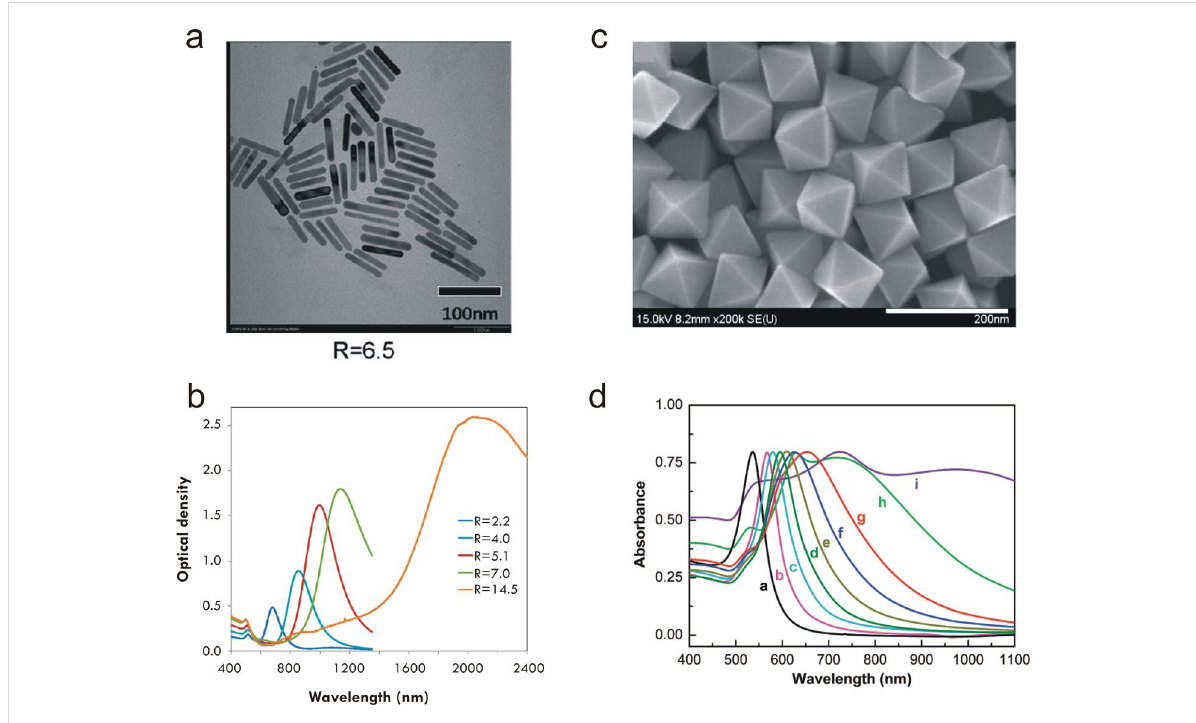
Figure 4: (a) TEM image of gold nanorods (AuNRs) with an aspect ratio R equal to 6.5. (b) UV–vis measurements showing the experimental spectra of longitudinal and transverse LSPRs for AuNRs with various aspect ratios (c) TEM image of gold octahedra with an edge length of 95 nm. (d) UV–vis absorption spectra for Au octahedra with different edge lengths (20, 50, 63, 80, 95, 110, 125, 160, and 230 nm, from curve a to curve i, respectively) dispersed in water. Figures adapted with permission from [9], Copyright 2008 American Chemical Society, and from [12], Copyright 2009 American Chemical